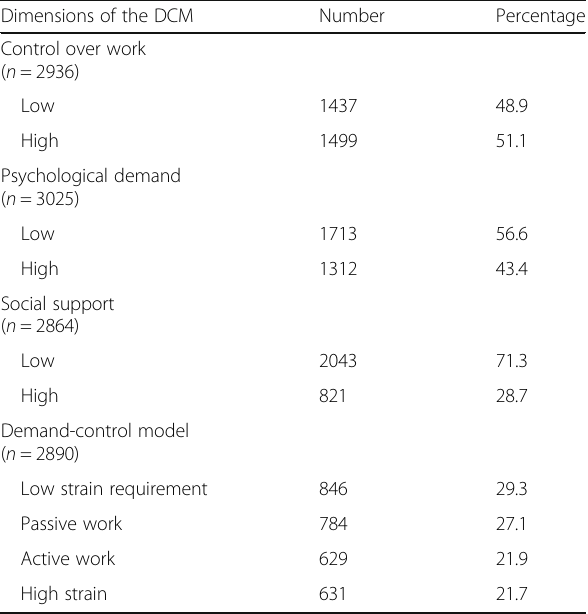
Table 1 Dimensions of the demand-control model.